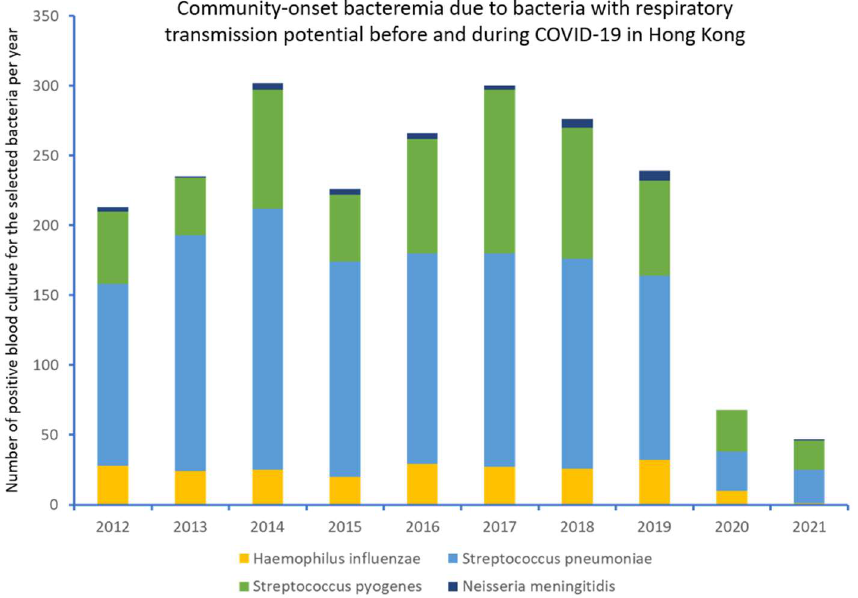
Figure 5. Community-onset bacteremia due to pathogens with respiratory transmission potential before and during COVID-19 in Hong Kong. Note: the pathogens with potential respiratory transmission include Streptococcus pyogenes , Streptococcus pneumoniae , Haemophilus influenzae and Neisseria meningitidis.